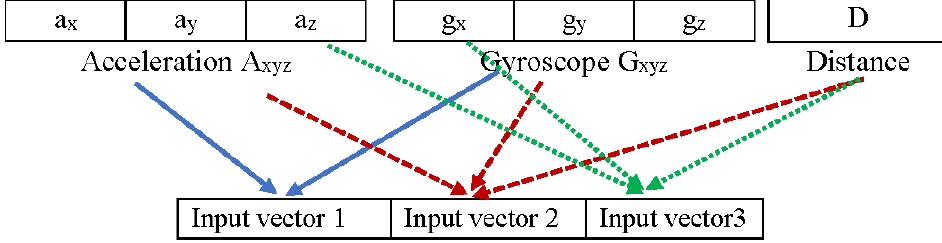
Figure 5. Feature sets for input vectors.